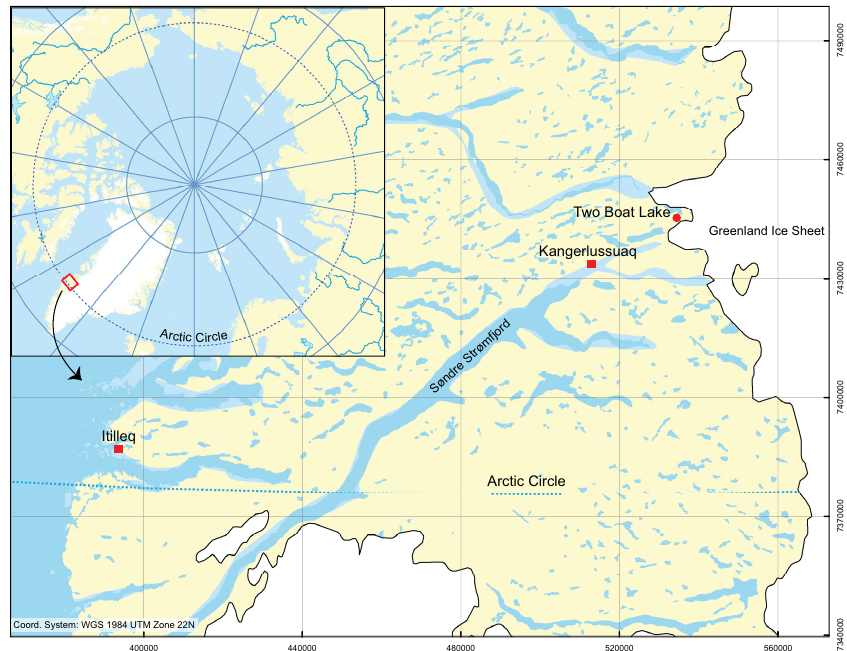
Figure 1. Map of West Greenland and location of Two Boat Lake catchment area. Modified from Johansson et al. (2015a).